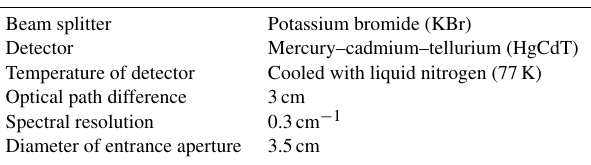
Figure 2. Sketch of IFS 55 Equinox. The blackbody SR-80 can be removed; then atmospheric radiation is measured. Table 2. Technical specifications of the FTIR spectrometer IFS 55 Equinox.